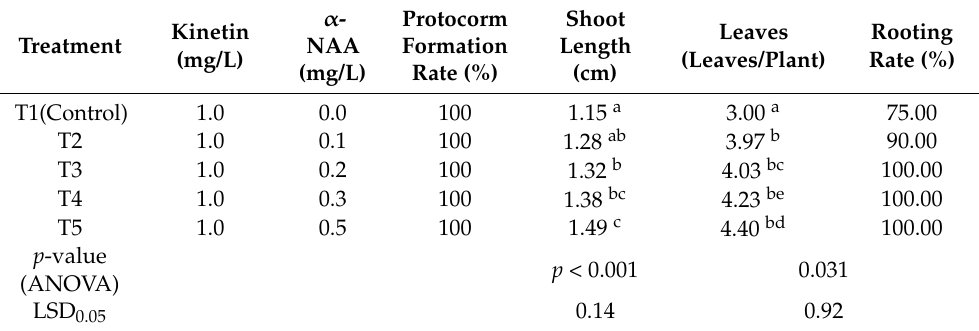
Table 4. Effect of kinetin and α -NAA on the regeneration efficiency of the D. anosmum Lindl. proto- corms (10 weeks after